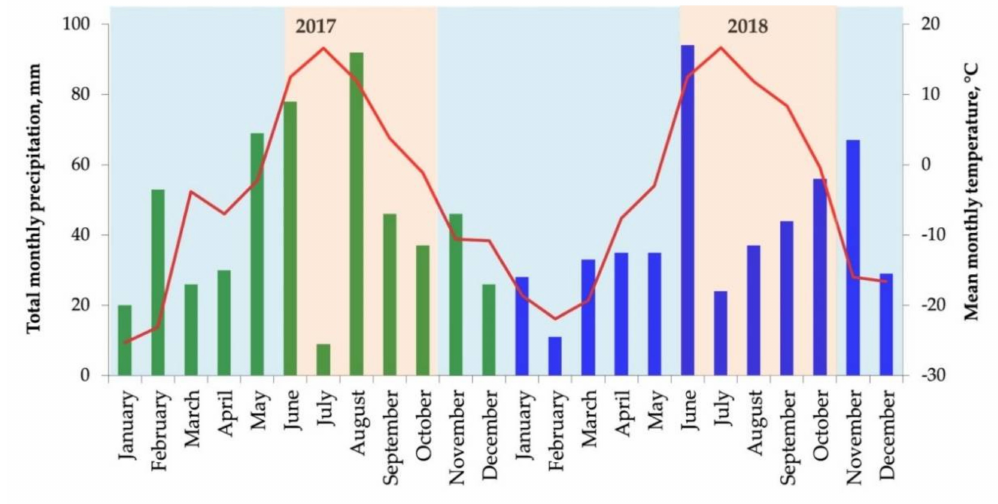
Figure 2. Mean monthly temperature (red line graph) and total monthly precipitation (bar graph, green color in 2017 and blue color in 2018) over two years for Nadym (warm periods are colored beige; cold periods are colored light blue) based on weather archive data